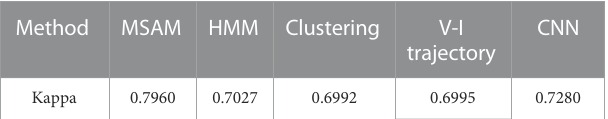
TABLE 3 Kappa statistics measure of different